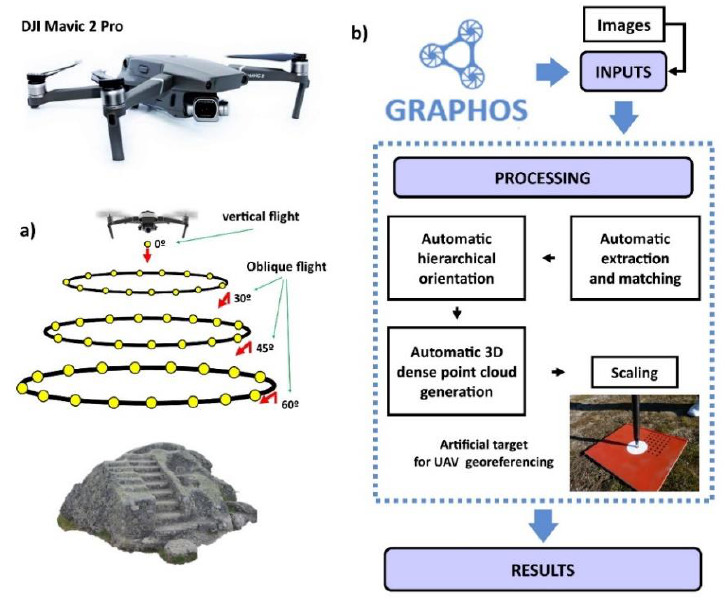
Figure 7. DJI Mavic 2 Pro. ( a ) Flight plan following an oblique/convergent photographic shooting protocol for the documentation of the monuments within the Ulaca oppidum , ( b ) Workflow for the photogrammetric processing of images when obtaining 3D point clouds. Table 2. UAV sensor ’s specifications.